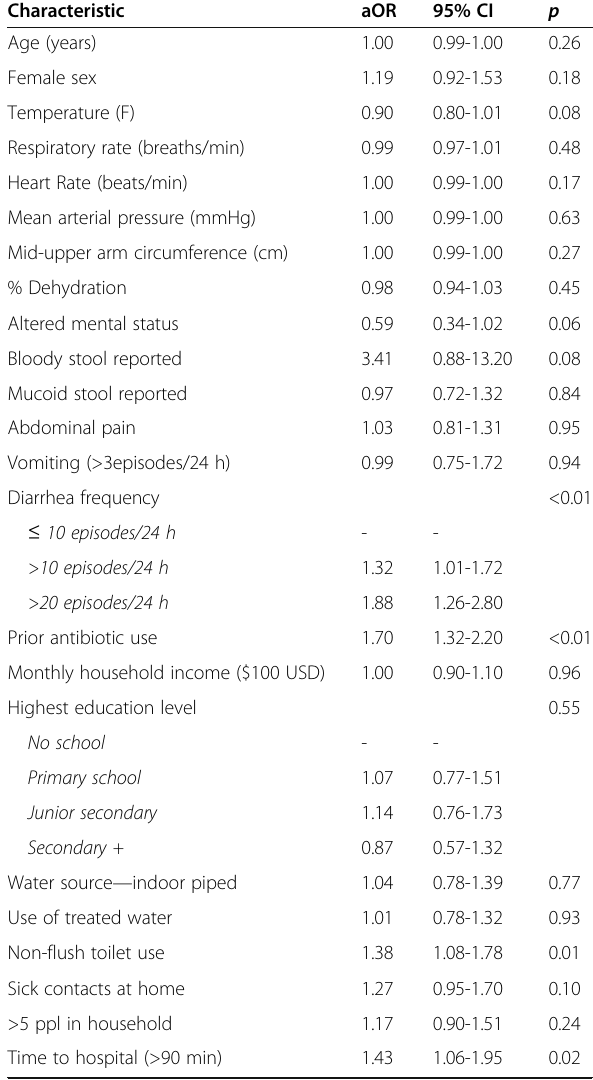
Table 5 Multiple logistic regression analysis of variables and association with multidrug-resistant organisms